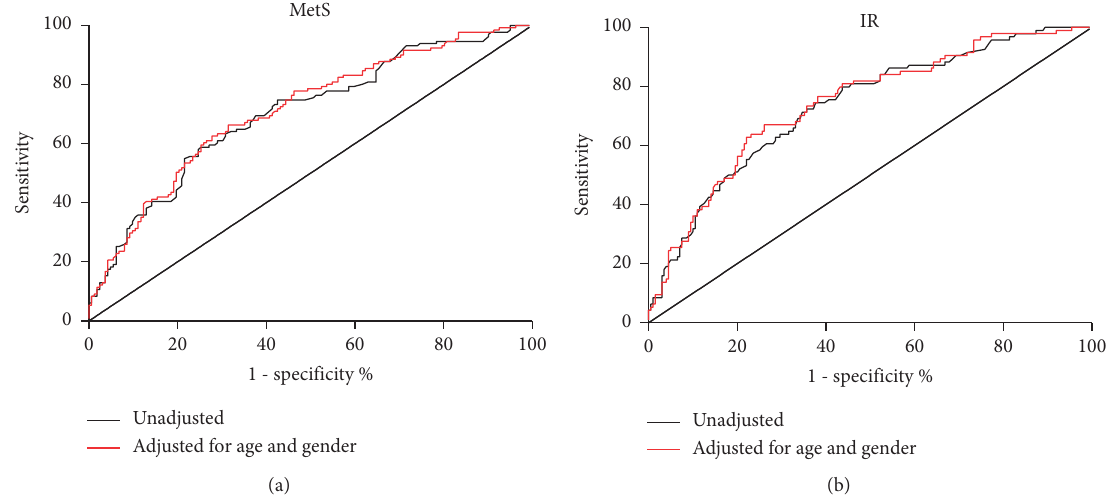
Figure 2: ROC curve analyses ROC curve analyses were performed for the prediction of serum asprosin for 16 MetS (a) and IR (b). MetS, metabolic syndrome; IR, insulin